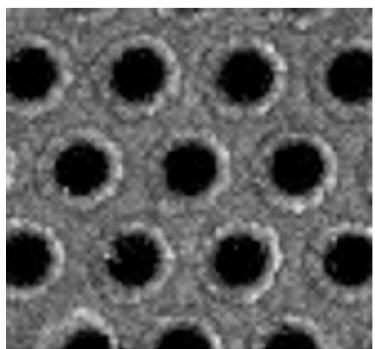
Figure 4. Scanning electron microscope (SEM) image of a typical nanostructured gold layer produced by Plasmore S.r.l., with a hexagonal plasmonic lattice (lattice pitch = 500 nm). Top of polymeric pillars corresponds to the black areas.